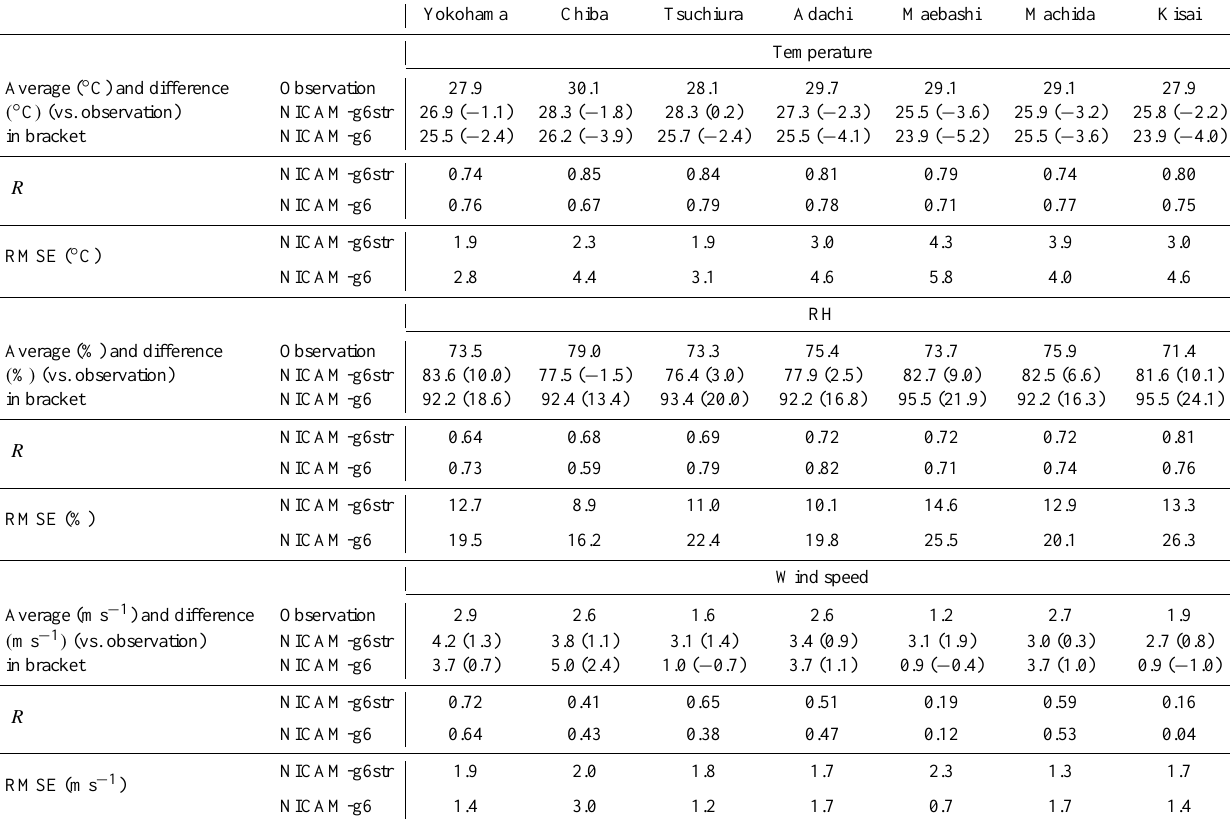
Figure 2. (a) EC and (b) SO 2 emission inventories in 2007. Table 1. Statistical values (averages of the observation and simulations, correlation coefficient R and root mean square error RMSE) for meteorological fields using the simulations (NICAM-g6str and NICAM-g6) and observations at seven sites during the same period, as shown in Figs. 4 to 7. Yokohama Chiba Tsuchiura Adachi Maebashi Machida